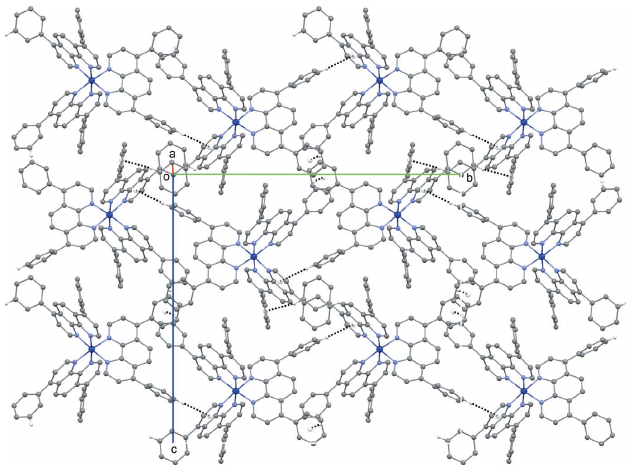
Figure 3 A view of the crystal packing along the a axis. The C—H (cid:2)(cid:2)(cid:2) (cid:2) hydrogen bonds are shown as dashed